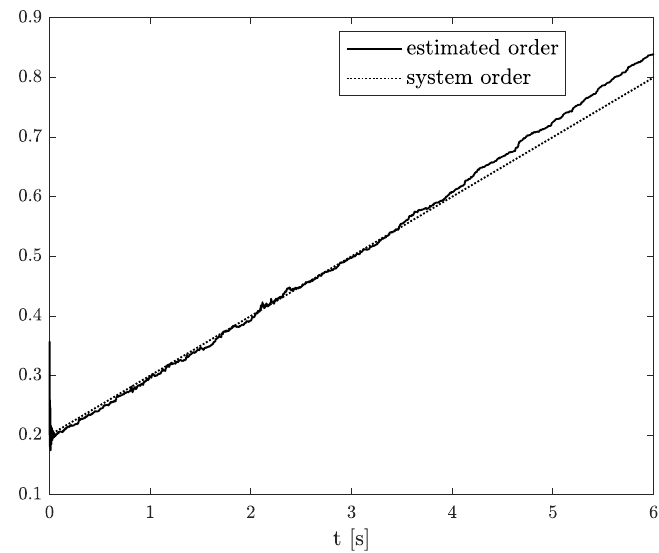
Figure 6. Original and estimated order from Example 2.